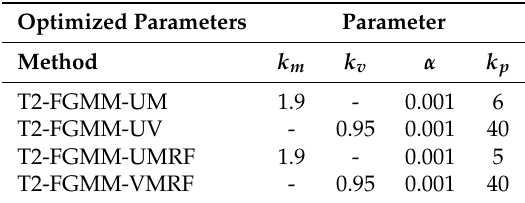
Table 8. Optimized parameters for T2-FGMM